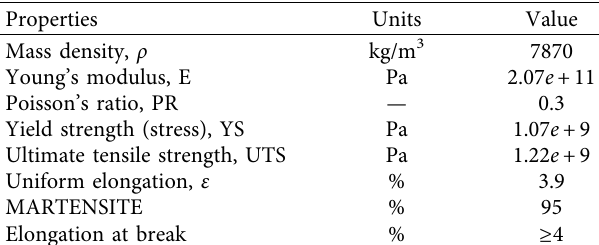
Table 4: Side beam material property.